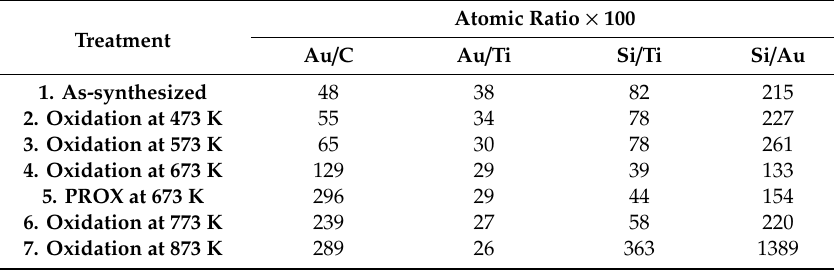
Table 3. Surface atomic ratios determined by XPS for the in situ sequence performed inside the high-pressure cell for the Au@G0 / TiO 2